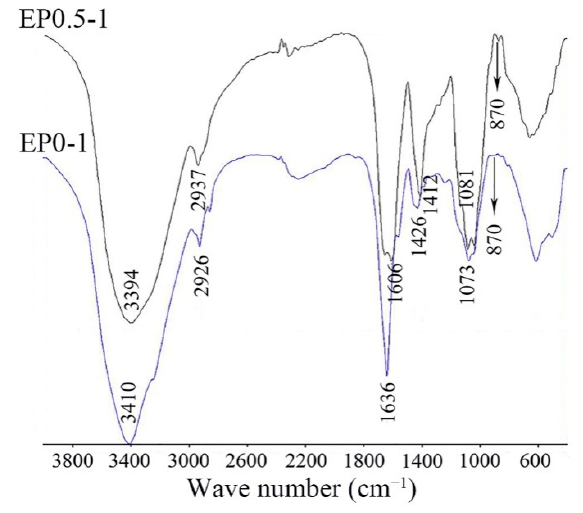
Figure 2. IR spectrum of EP0-1 and EP0.5-1.